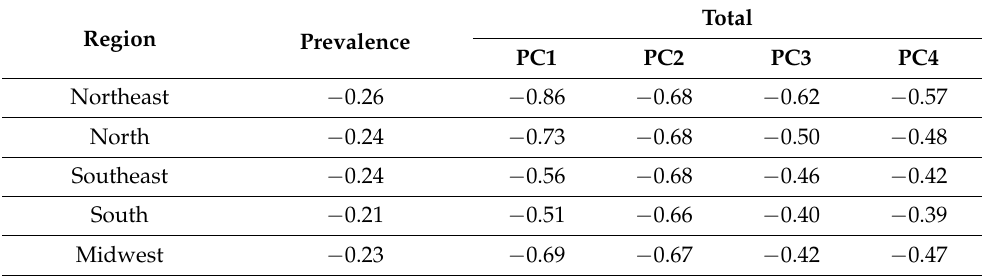
Table 1. Price-elasticities by regions and price categories. Total Region Prevalence PC1 PC2 PC3 PC4 Northeast − 0.26 − 0.86 − 0.68 − 0.62 − 0.57 North − 0.24 − 0.73 − 0.68 − 0.50 − 0.48 Southeast − 0.24 − 0.56 − 0.68 − 0.46 − 0.42 South − 0.21 − 0.51 − 0.66 − 0.40 − 0.39 Midwest − 0.23 − 0.69 − 0.67 − 0.42 −